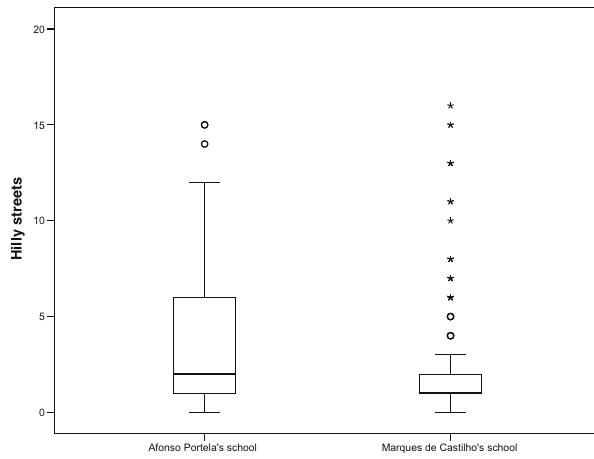
Fig. 3 Boxplots of the perceived importance levels of the B Hilly streets ^ barrier by the students of the Afonso Portela and Marques Castilho ’